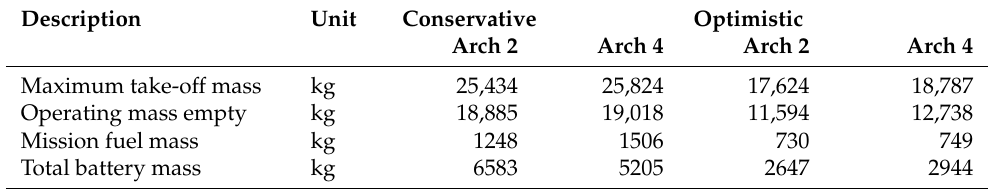
Table 8. Results on the masses from the initial sizing for Architecture 2 (TP) and 4 (DEP). Description